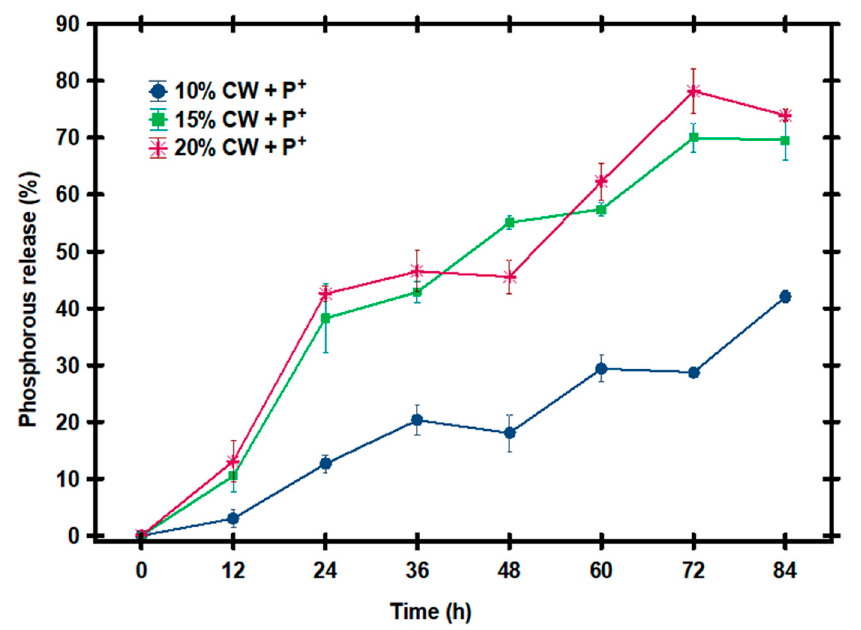
Figure 4. Cumulative percentages of phosphorus release (P + ) of oleogels with 10%, 15% and 20% candelilla wax (CW) in an aqueous medium for 84 h.